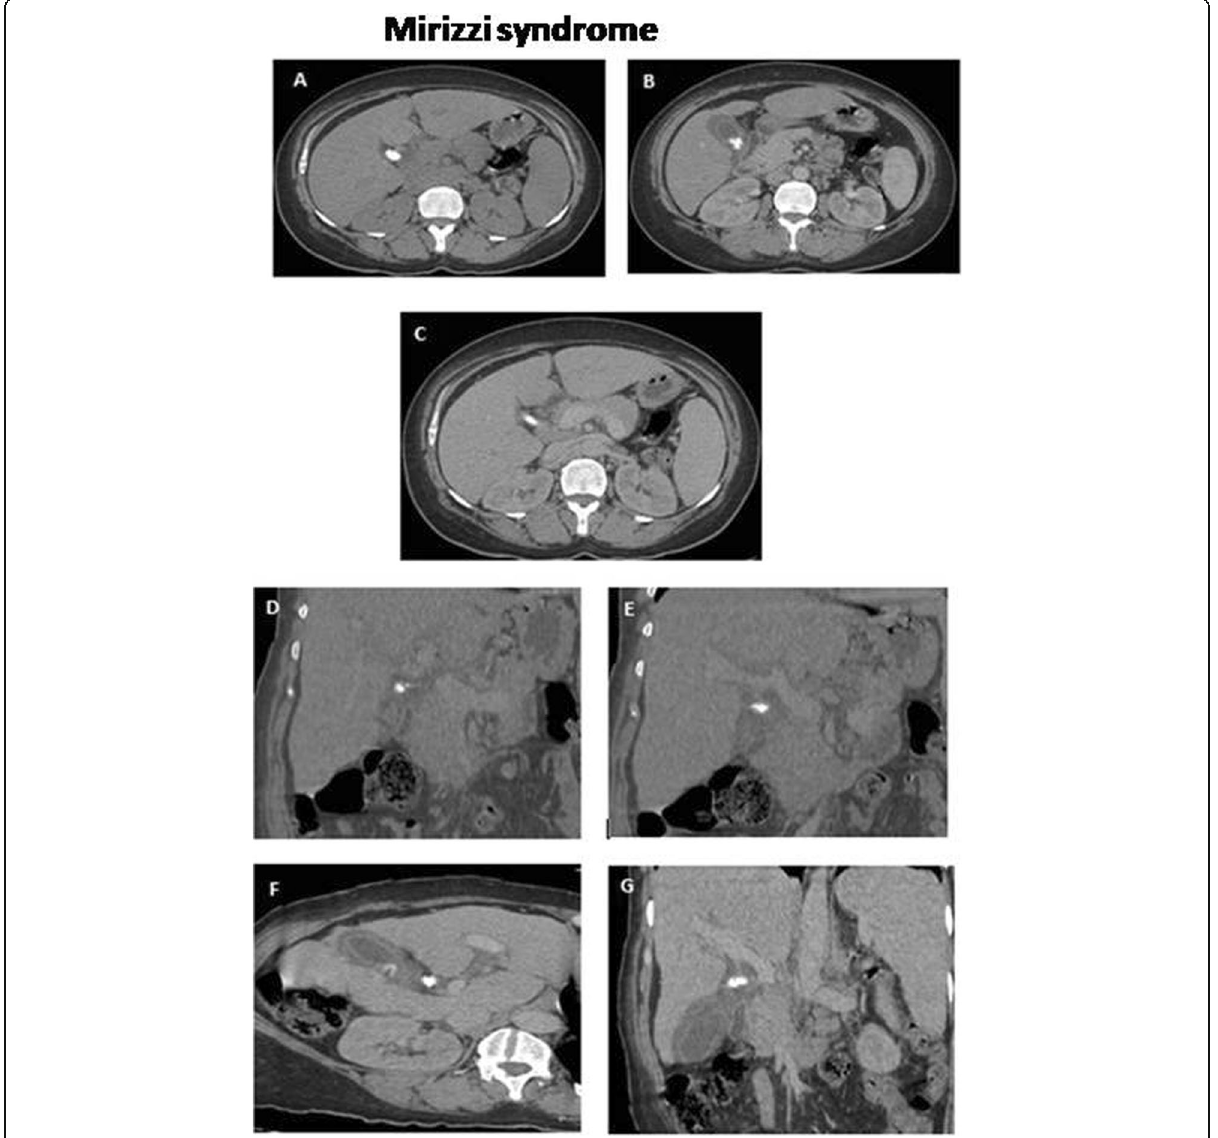
Fig. 2 Mirizzi syndrome. Mirizzi syndrome due to impacted cystic duct stones exerting minimal extrinsic intra-hepatic biliary dilatation in a patient with calcular cholecystitis. Female patient, 48 years old, presented with epigastric pain, intermittent attacks of jaundice, and fever. a Axial pre- contrast image showing impacted stone at the level of the cystic duct. b Axial (arterial phase) and c axial (portal phase) images that show partially contracted GB over dense GB stones with surrounding minimal peri-cholecystic free fluid associated with two impacted cystic duct stones exerting extrinsic minimal intrahepatic biliary dilatation and normal caliber CBD. d , e Coronal reformatted MDCT cholangiography images showing two adjacent impacted cystic duct stones more clearly. f , g Axial and coronal oblique reformatted MDCT cholangiography images showing the cystic duct with its impacted stones and the GB in one